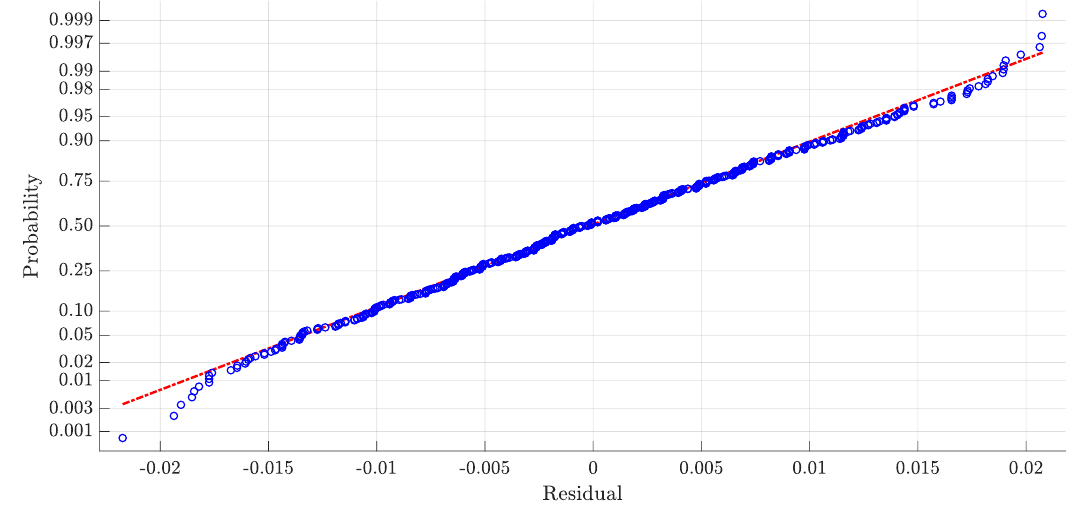
Figure 5. Plot of normal probability of residuals (response optimal